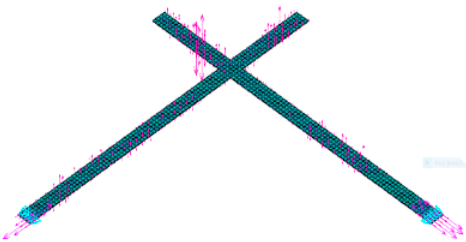
Figure 32. FEM simulation comparison between equivalent test loads and real uniformly distributed load for slab BS1.